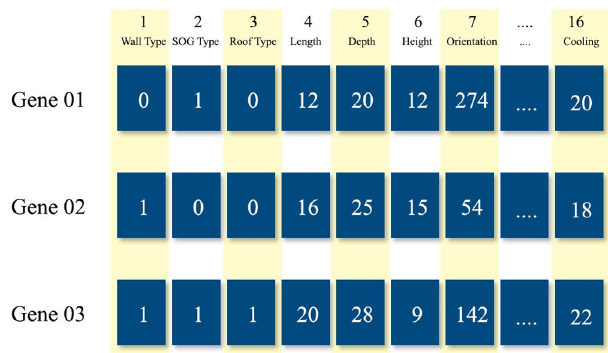
Figure 2. Solutions’ (Genes’) Representation.